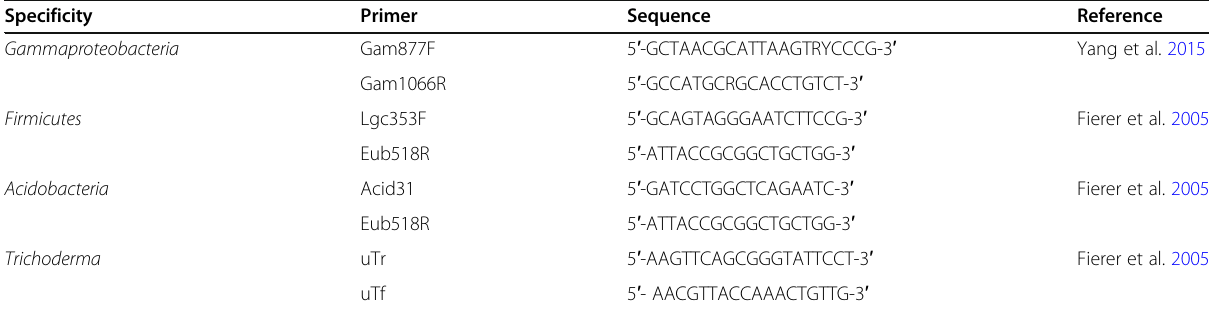
Table 1 Primers used qPCR